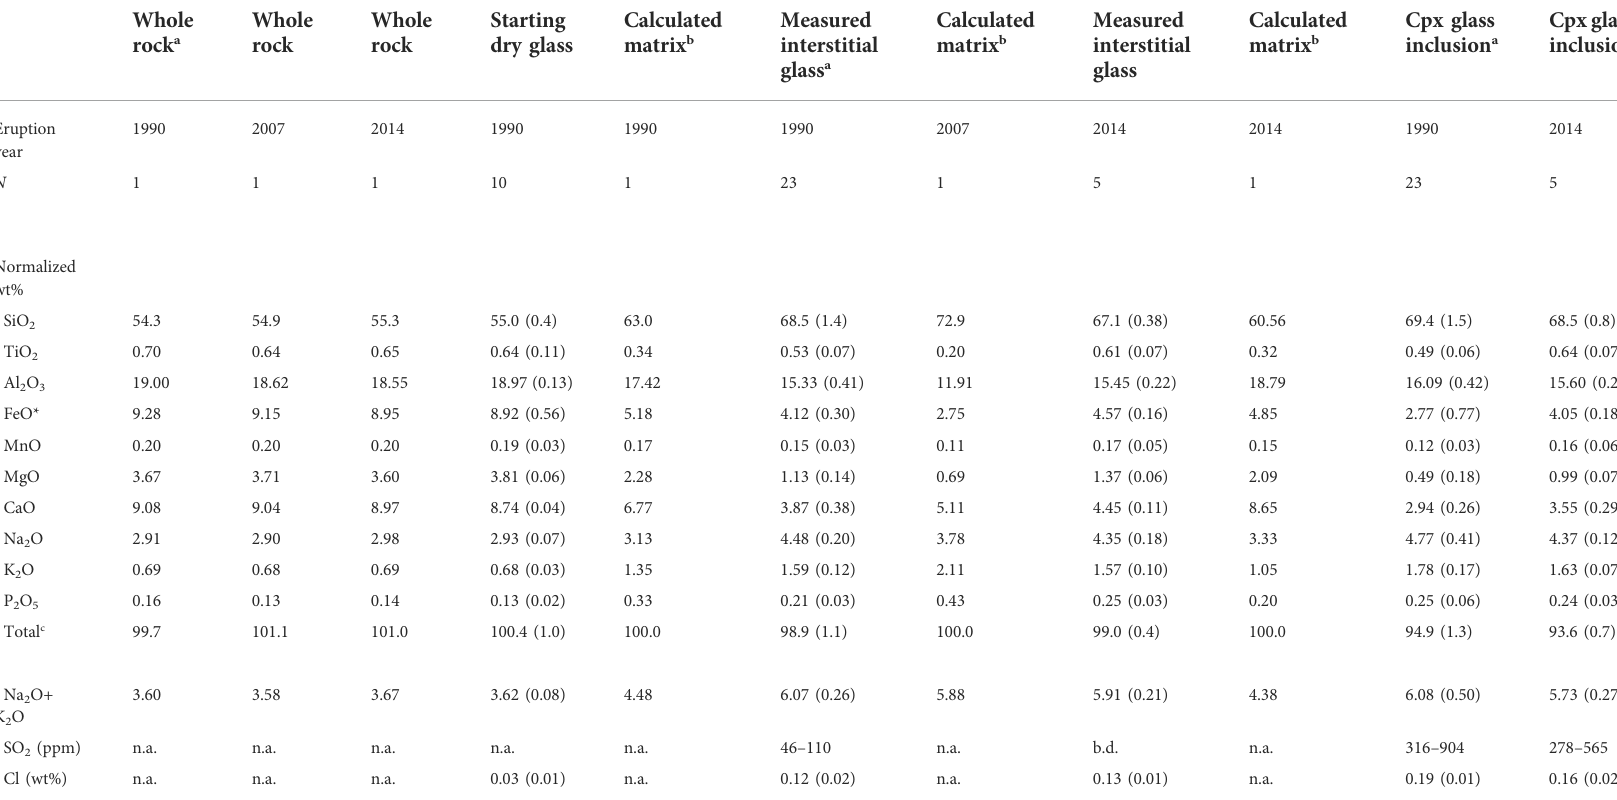
TABLE 1 Representative whole rock and glass compositions for the starting glass, whole rock, clinopyroxene-hosted melt inclusions, and interstitial glass from the 1990, 2007, and 2014. Whole rock